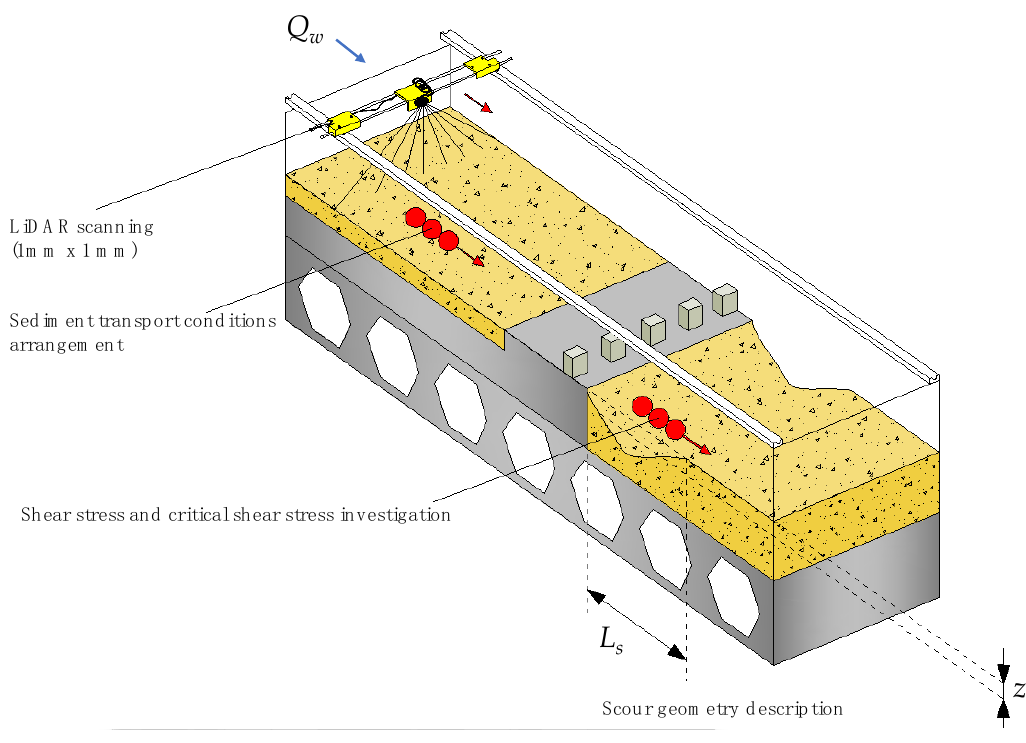
Figure 12. Upstream and downstream conditions investigated during each experimental series, where: z m —medium scour depth; L s —local scour length.